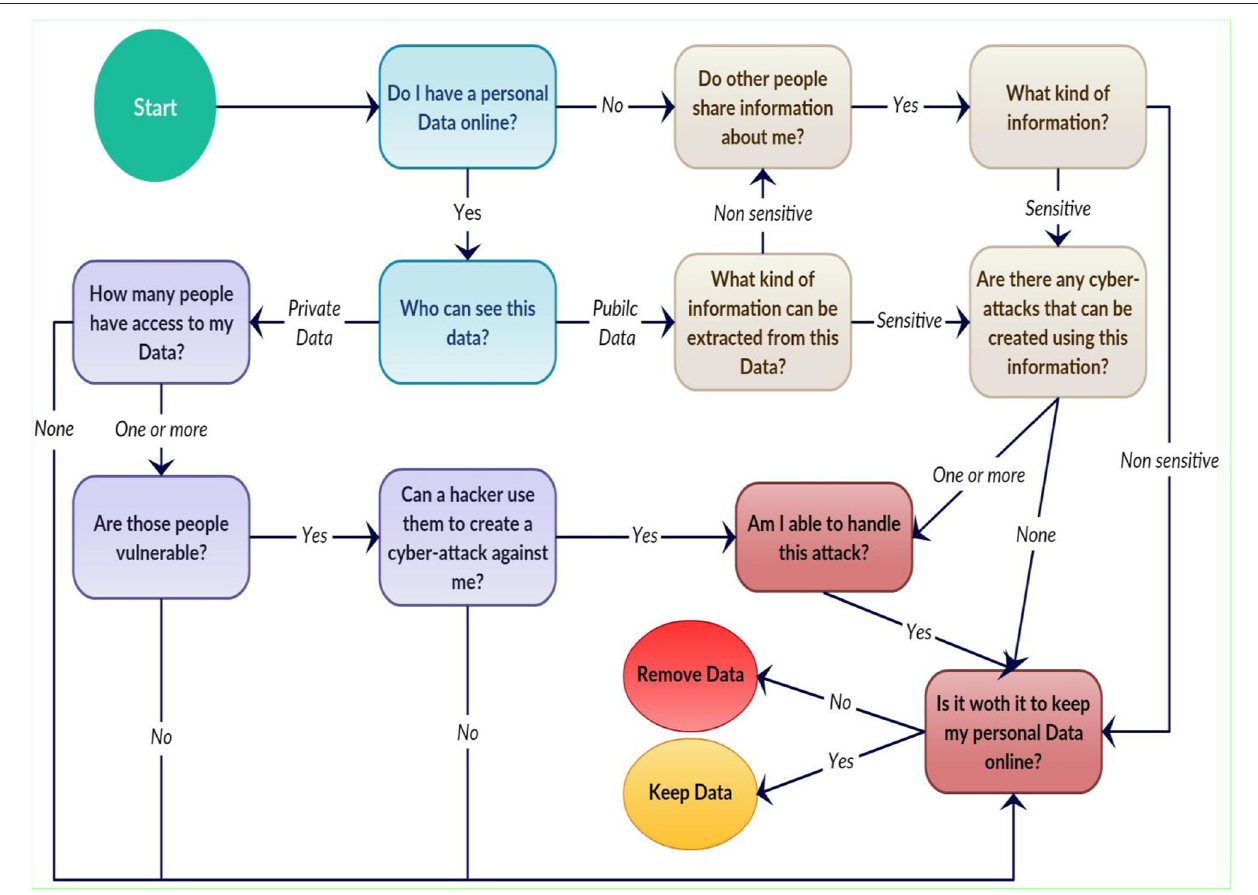
FIGURE 5 | Security and privacy critical thinking